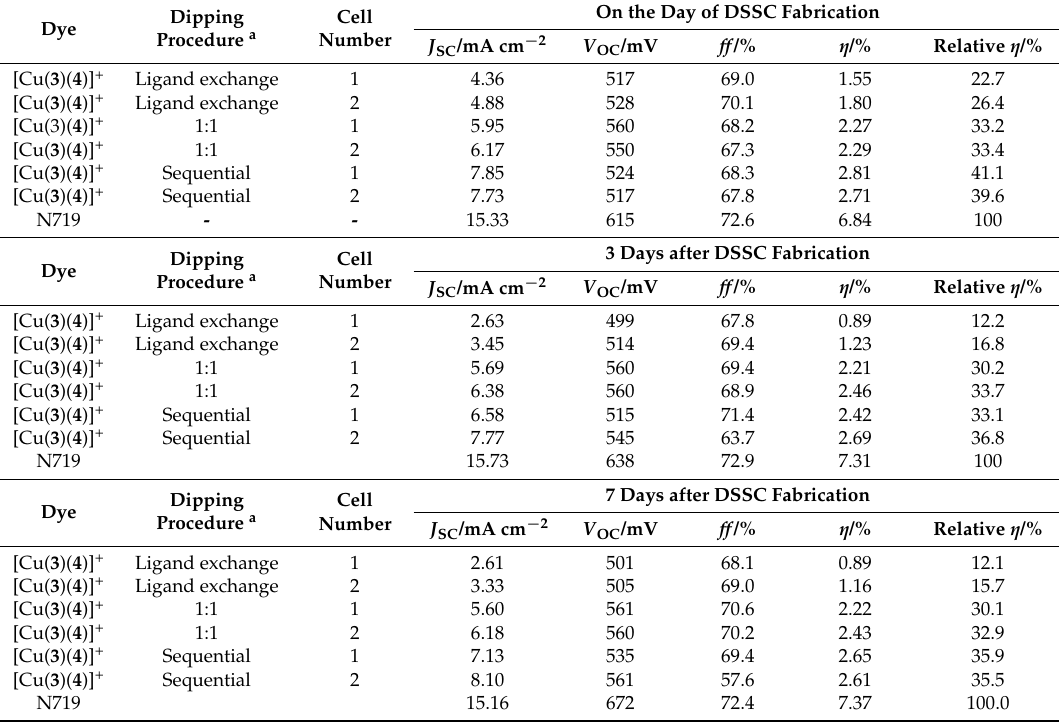
Table 3. Performance parameters (under 1 sun illumination) of duplicate, masked DSSCs with [Cu( 3 )( 4 )] + on the day of sealing the cells, and after 3 and 7 days. The data are compared to a DSSC containing N719 and relative η values are with respect to N719 set at 100%.